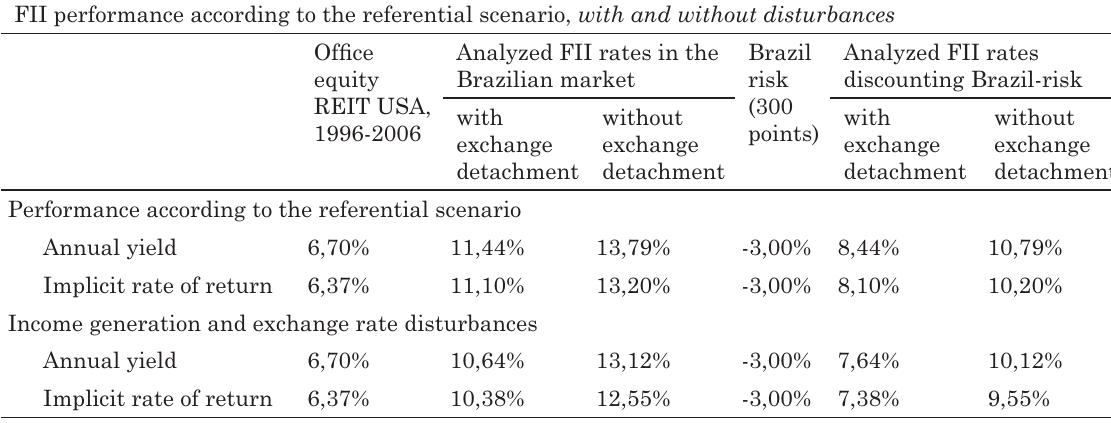
Table 8. Investment quality indicators – Brazilian FII versus the NAREIT indexes FII performance according to the referential scenario, with and without